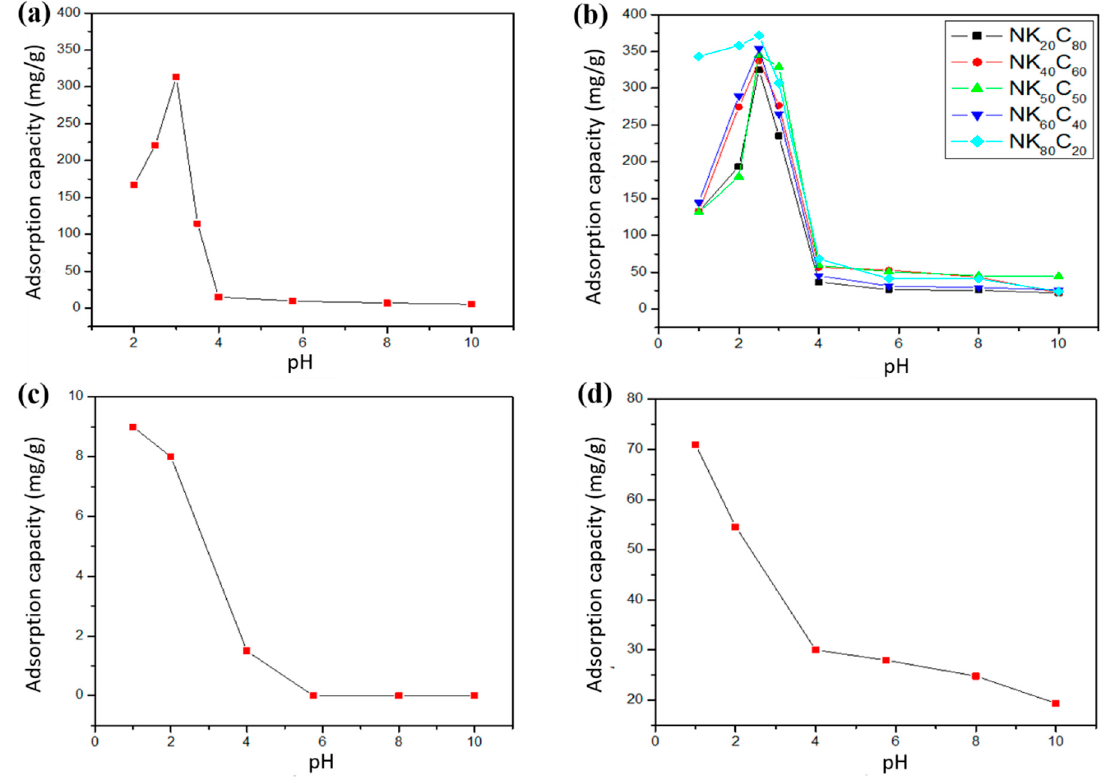
Figure 1. Effect of pH on the adsorption capacity of ( a ) chitosan, ( b ) nanocomposites (NCPs), ( c ) kaolinite, and ( d ) activated charcoal.